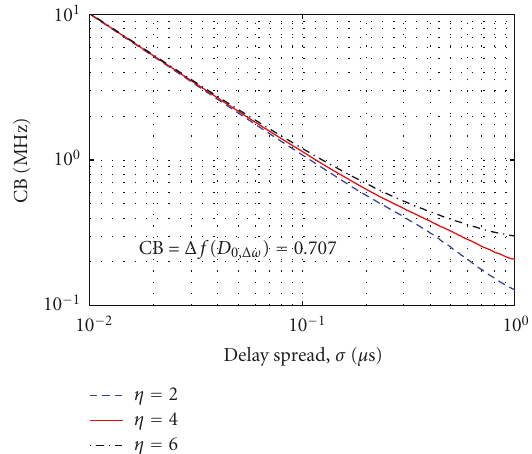
Figure 6: Coherence bandwidth , with respect to the delay spread σ ; using exponential DP with mean, τ = 3 . 33 microseconds, t 1 = t 2 = 1 second, f 1 = 4GHz, κ 2 = 0, SISO communication system and for di ff erent propagation environments with di ff erent pathloss exponents η : free space (typical urban), crowded urban or rural environments with η = 2,4, or 6,